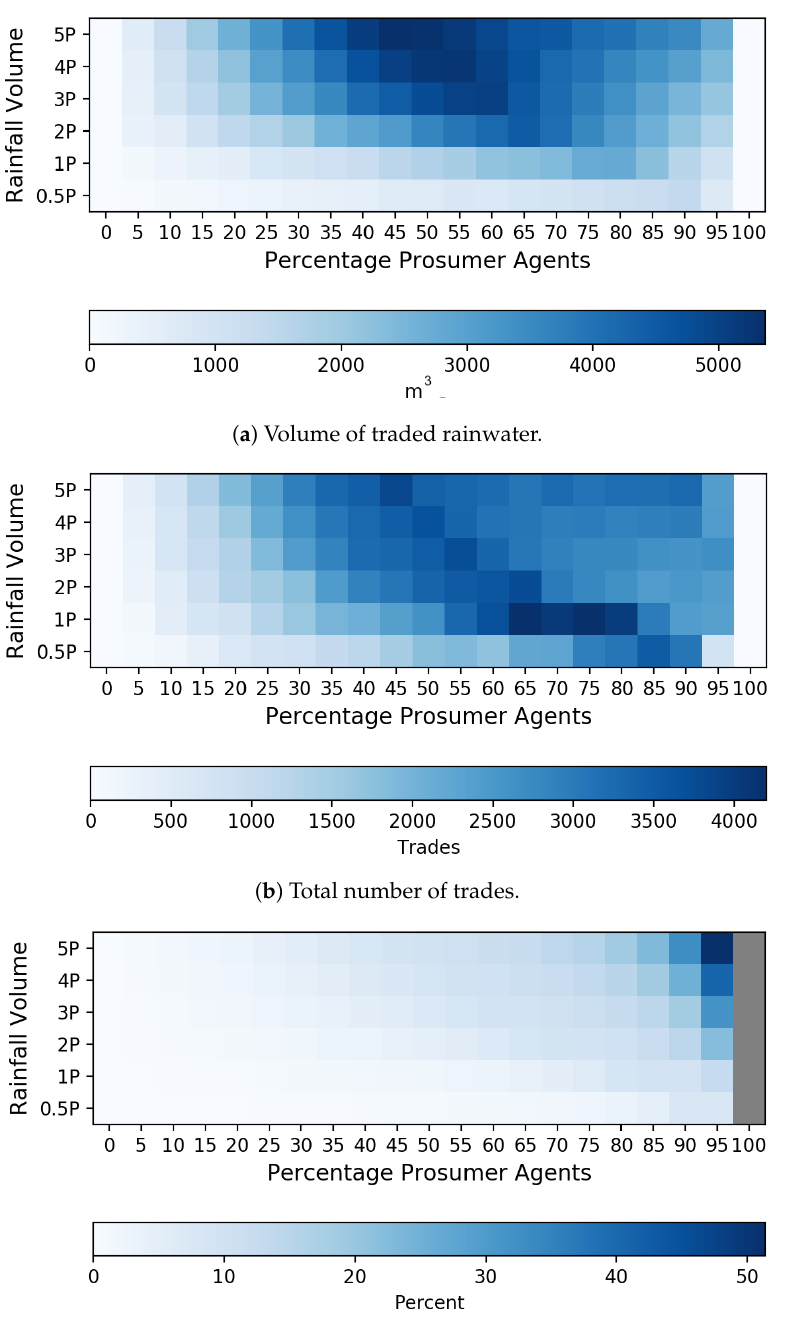
Figure 8. Total volume of traded rainwater (m 3 ), total number of trades, and total percentage of irrigation demand satisfied by traded rainwater across 126 scenarios of varying rainfall depth and percentage of prosumer